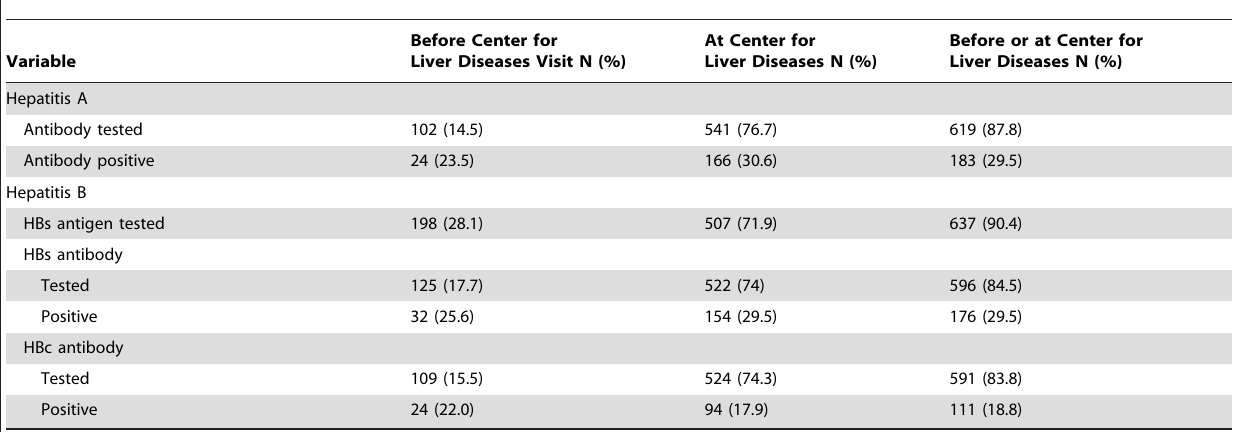
Table 2. Number of new patients with chronic liver disease tested for Hepatitis A and B immunity before or at the liver clinic in the year